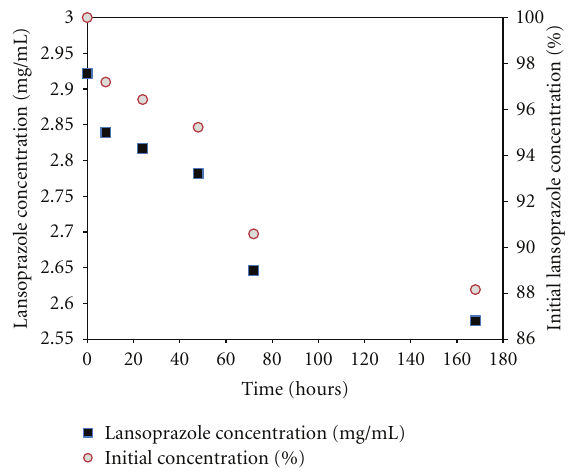
Figure 3: Graphical representation of the results of the pilot stabil- ity sample, lansoprazole 3mg/mL suspension stored at room tem- perature for 7